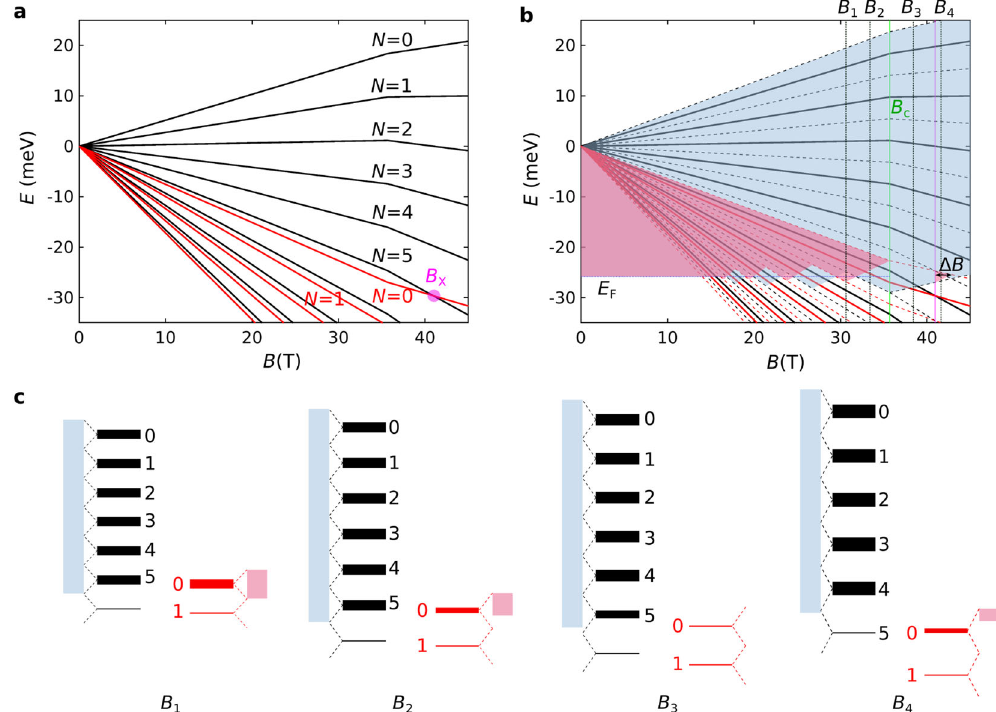
Fig. 4 LL fan diagram and valley- fi lling instability. a LL fan diagram for ML WSe 2 valence band with a hole density of 5.2 × 10 12 cm − 2 ( E F = 25.8 meV). The LLs are labeled by the LL index N and black/red lines and labels represent LLs in valley K / K 0 . The slopes of the plots decrease in magnitude when B increases beyond B c , leading to a crossing between ð 0 ; K 0 Þ and (5, K ) (purple circle). b Hole occupancies of LLs in valley K / K 0 _ ω c ; ϵ denoted by blue/pink shading. If the N th LL at K is fully occupied with holes for ( B , B + δ B ), the region ð ϵ N ; K (cid:3) _ ω c (cid:4) is shaded for N ; K þ 2 2 . Holes preferentially occupy LLs with higher energies, and each LL is fully occupied ( B , B + δ B ). Dashed fan diagram lines indicate ϵ N ; K ± _ ω c 2 before the next LL lower in energy, resulting in the zigzag-shaped fi ne-structure at E ~ E F . c Schematic fi gure for LLs at B 1 , B 2 , B 3 , and B 4 as marked in ( b ). The blue and pink shading represent the hole populations in K and K 0 , respectively. The thickness of the black and red lines representing the LLs indicates the hole occupancies of individual LLs in K and K 0 , respectively (a thicker line carries more holes, and the thinnest lines have no holes at